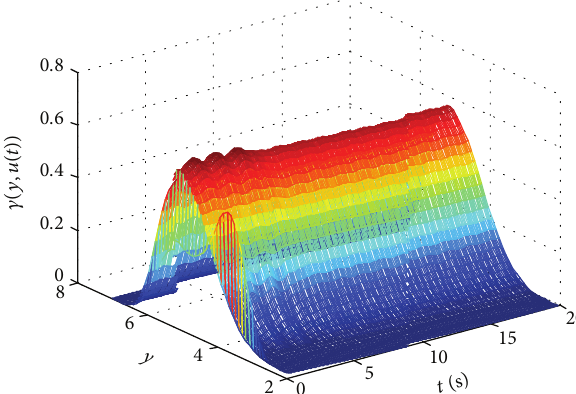
Figure 5: The output PDF of the whole process with fault tolerant